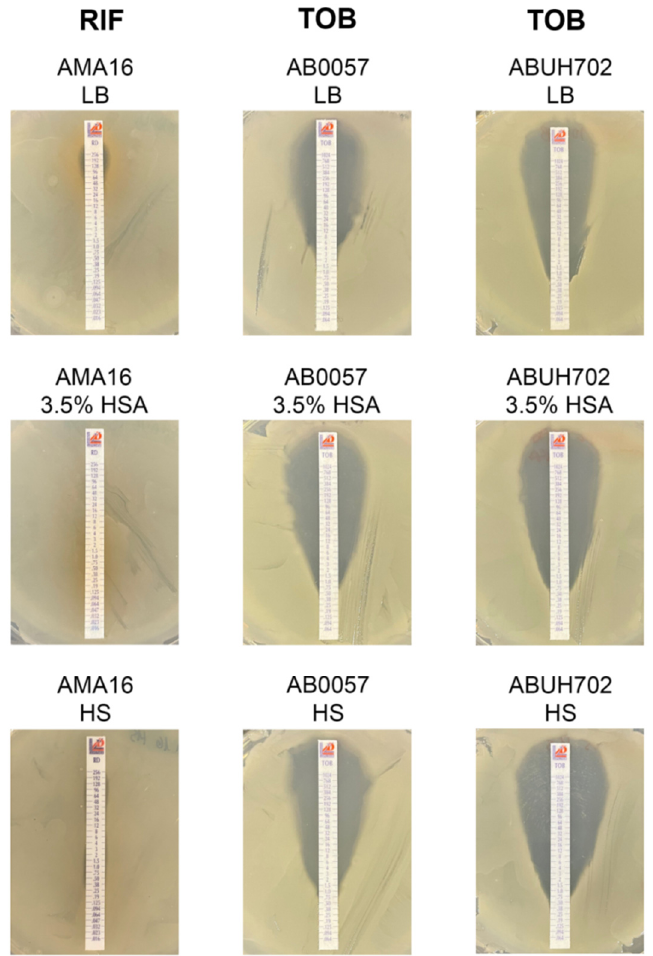
Figure 3. Effect of human serum albumin (HSA) and pooled normal human serum (HS) on the antimicrobial susceptibility of A. baumannii strains. AMA16, AB0057, and ABUH702 strains grew in LB broth, LB broth plus 3.5 % HSA, or in HS were used to performed rifampicin (RIF) and tobramycin (TOB) susceptibility. Minimum inhibitory concentration (MIC) was performed by E-test (Liofilchem, Italy) following CLSI recommendations.